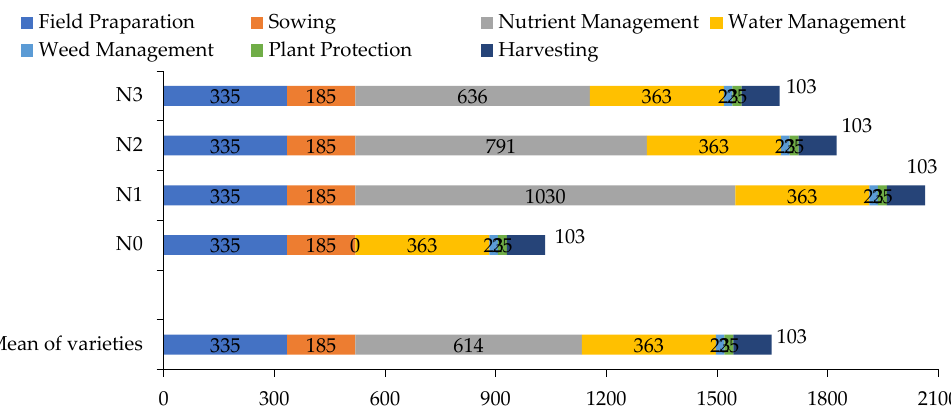
Figure 8. Source-wise mean share of carbon emission for the cultivation of fodder maize (mean of two years).